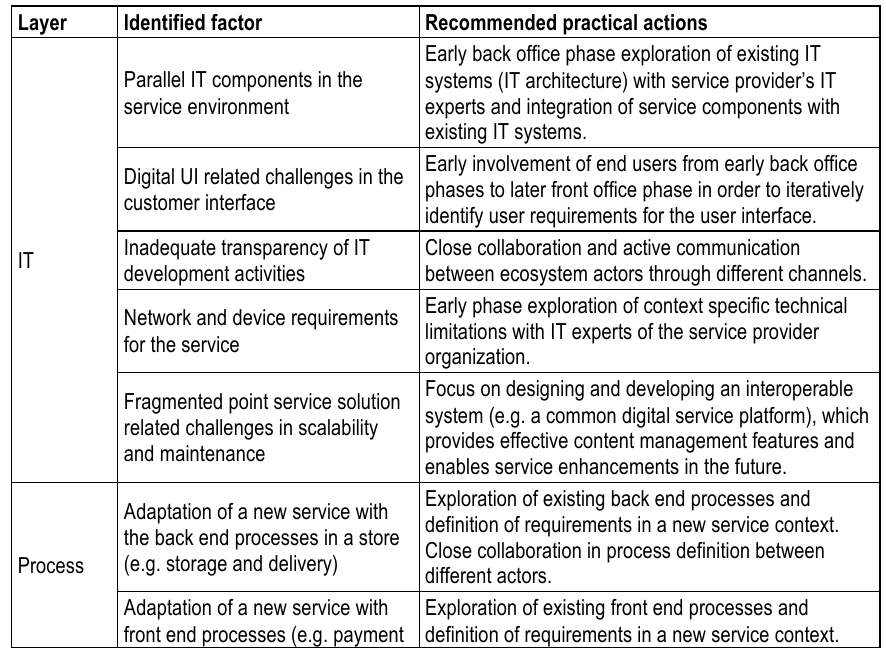
Table 4. Summary of identified factors and recommended actions that should be taken into consideration during a service innovation